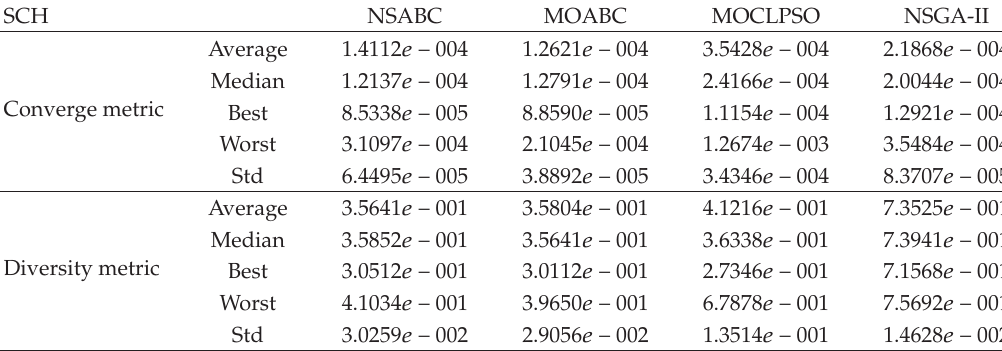
Table 2: Comparison of performance on SCH after 20000